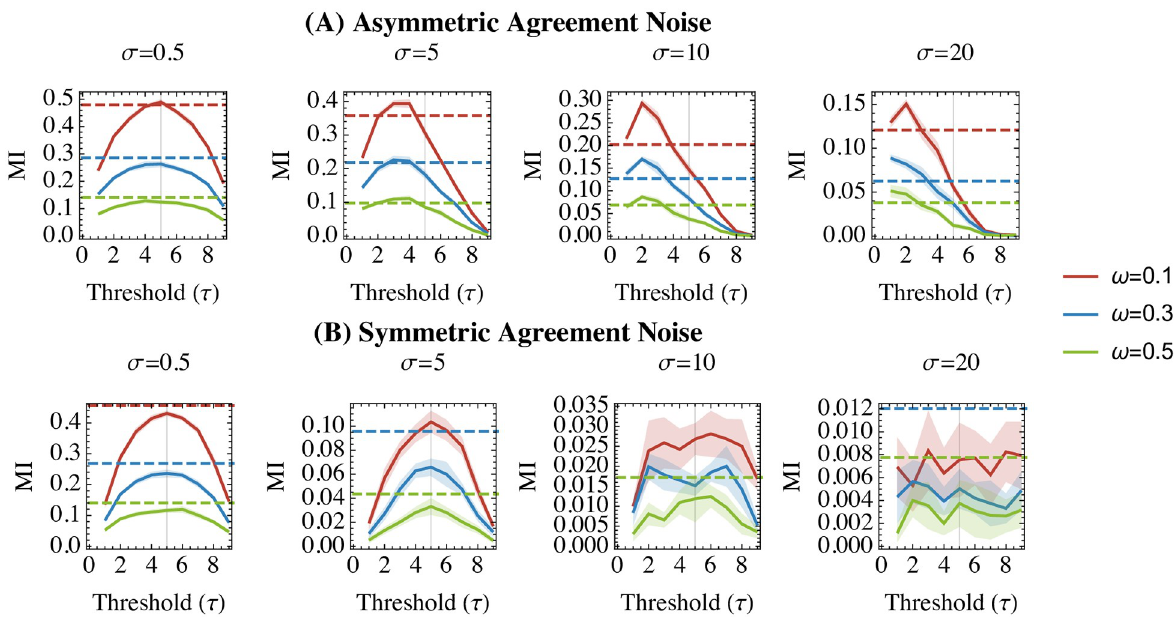
Fig 4. Mutual information (MI) for dichotomized (solid lines) and continuous (dashed lines) distributions on synthetic data with asymmetrical (upper row, Panel A) and symmetrical (lower row, Panel B) properties with respect to agreement. X-axes represent the dichotomization thresholds at which we recalculate the dichotomized MI. Mutual information is depicted on the y-axes. Plot titles indicate the different diagonal spread ( σ ) parameters used to synthesize the synthetic datasets. Solid lines (for dichotomized MI) are surrounded by ribbons depicting the 95% confidence intervals over 10 runs at each combination of parameters ( τ , ω , β , σ ).